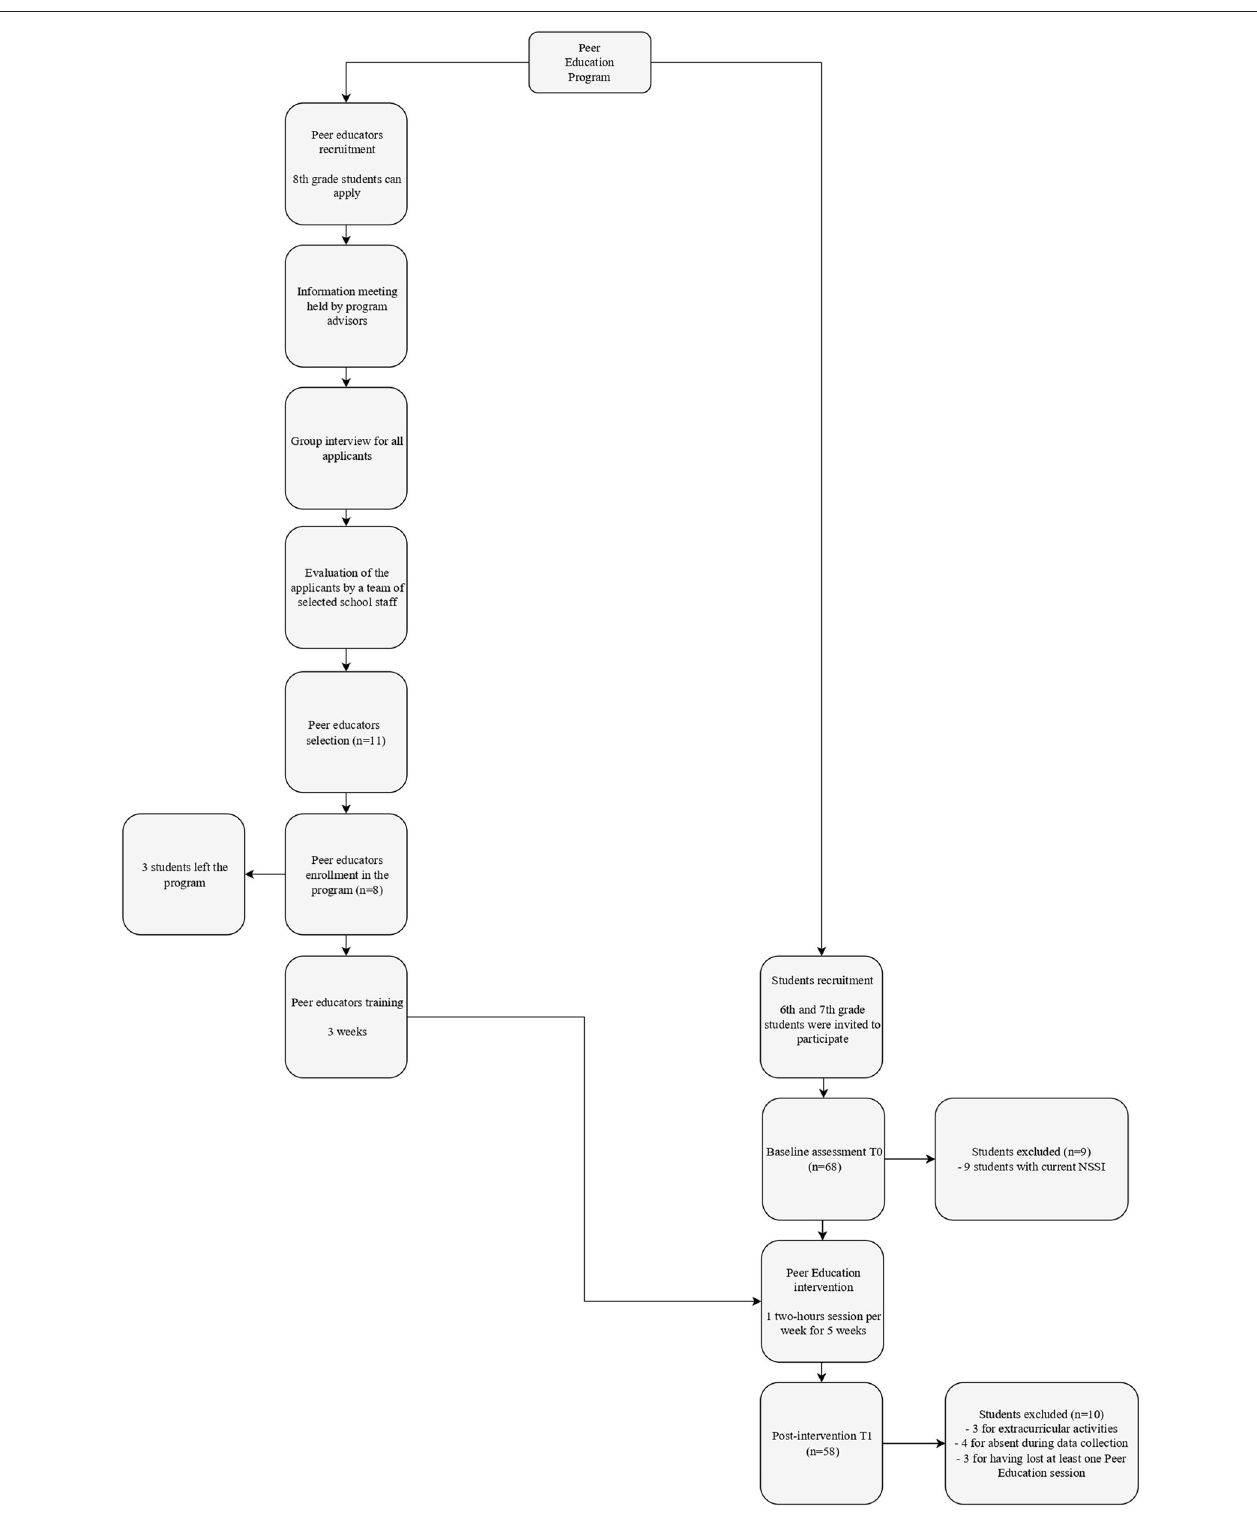
FIGURE 1 | Flowchart of the peer education